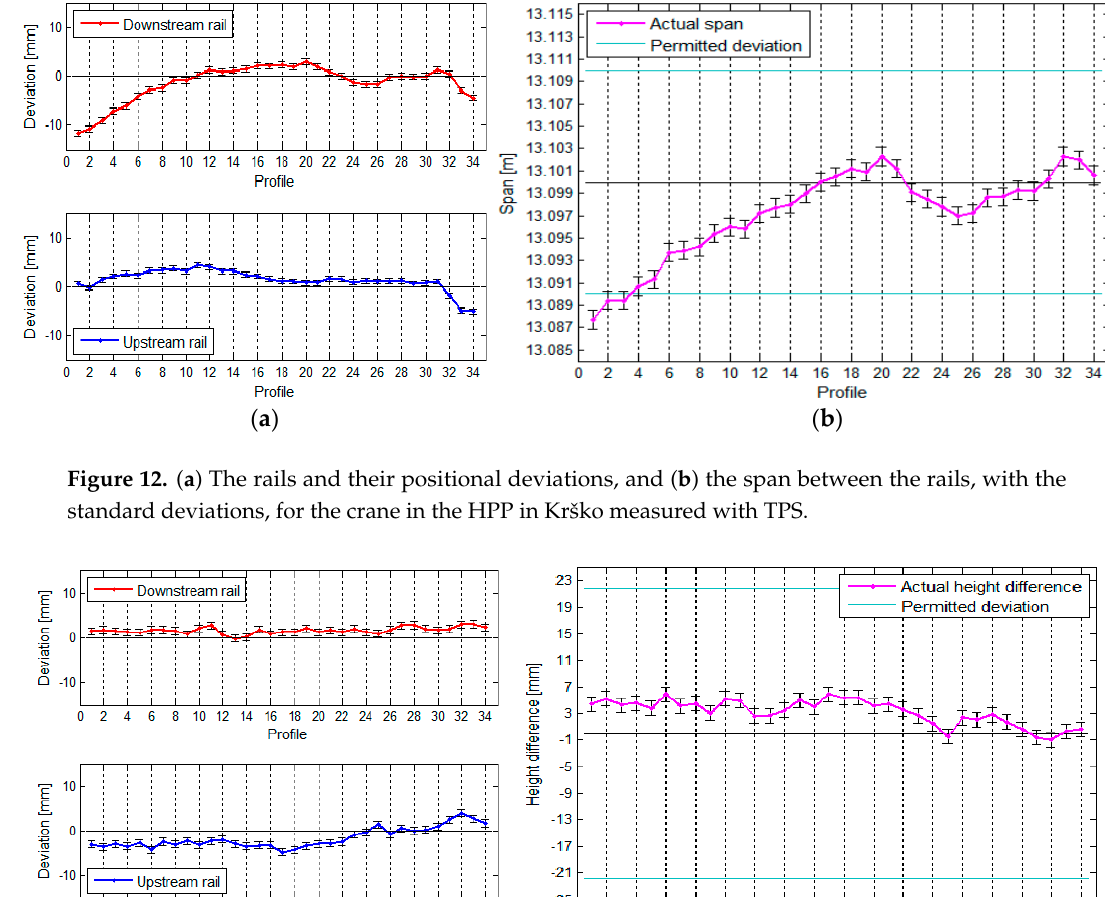
Figure 13. ( a ) The vertical deviations and ( b ) the height differences between the rails, with their standard deviations, for the crane in the HPP in Krško measured with TPS.